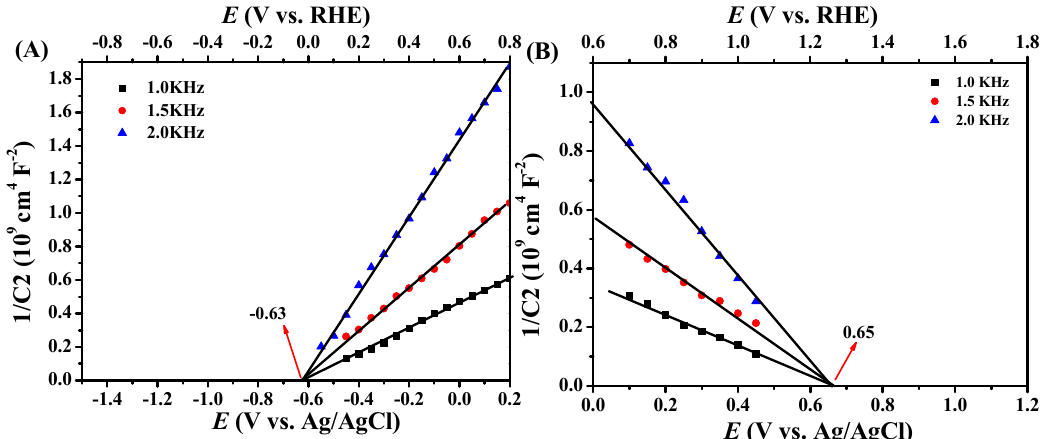
Figure 8. Mott-Schoottky plots of ( A ) TiO 2 nanorods and ( B ) Cu 2 O nanocubes measured at varied frequencies and room temperature. Solution: 0.1 M phosphate buffer (pH 7).